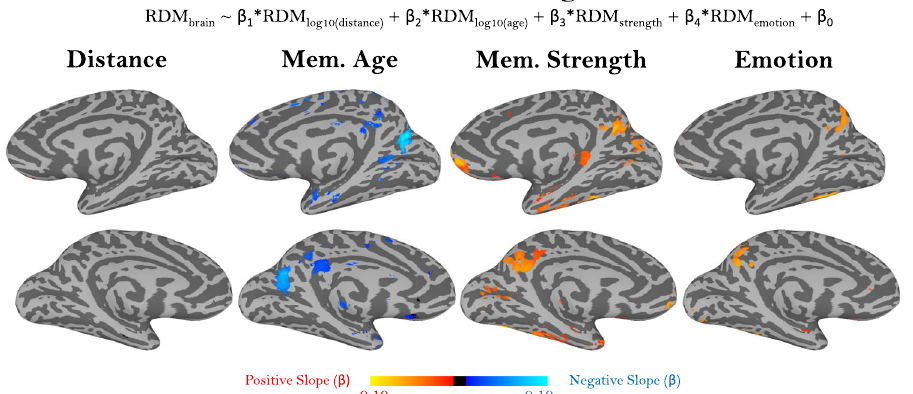
Fig. 7 | Representationalsimilarityanalysis of differentmemorycontent. Maps showing bilateral views of results from a multiple regression predicting the representational dissimilarity matrices (RDMs) of voxel beta values, from separate RDMs for a memory ’ s distance, age, strength, and emotion. Memory distance and age were logarithmically transformed before creating RDMs. Map color values